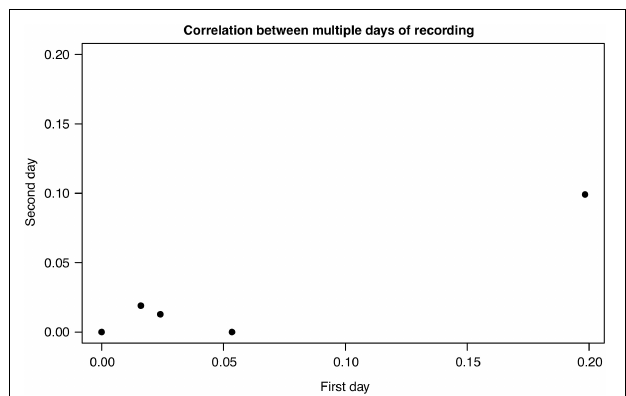
FIGURE 4 | The correlation between the first and second day of recording for five nests at which 2 days of recordings were available (Pearson’s product-moment correlation P = 0.017, R = 0.94). All nests were recorded on consecutive dates, except the nest at (0,0) which was recorded six days apart (see Supplementary Table S1